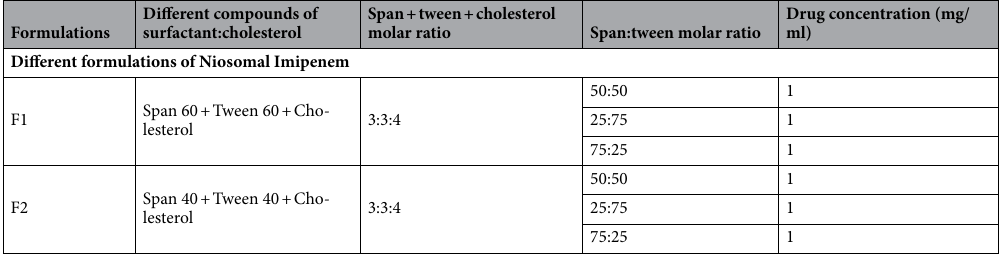
Table 1. Preparation of various Niosome-encapsulated imipenem